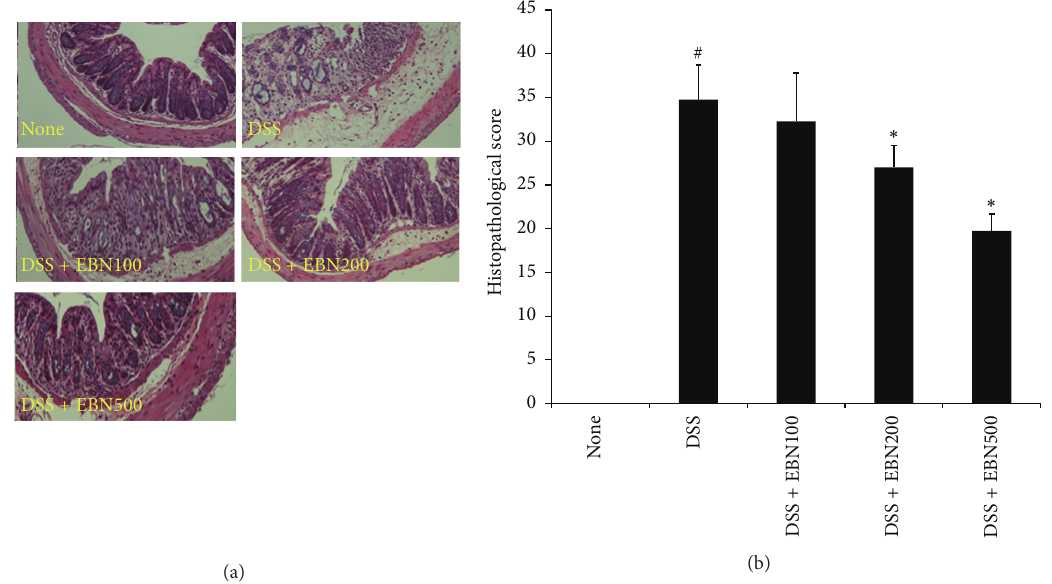
Figure 2: The effect of EBN on the histopathological score in DSS-induced colitis mice. Mice colons were obtained at 7 days post-DSS administration and were stained with H&E. H&E staining was performed on colon sections obtained from mice belonging to the untreated (no DSS), DSS-treated (3% DSS), DSS + EBN 100 (3% DSS and EBN at 100mg/kg body weight per day), DSS + EBN 200 (3% DSS and EBN at 200 mg/kg ⋅ d), and DSS + EBN 500 (3% DSS and EBN at 500 mg/kg ⋅ d) groups. Images were obtained at 40x magnification (a). Histopathological scores were analyzed from slides (b). Data from 3 independent experiments is shown and expressed as the mean ± SD ( 𝑛 = 8 per group). ∗ 𝑃 < 0.05 versus DSS-treated; # 𝑃 < 0.05 versus